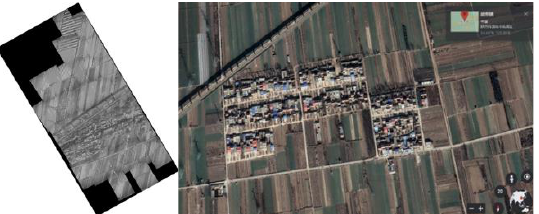
Figure 5 . Experimental